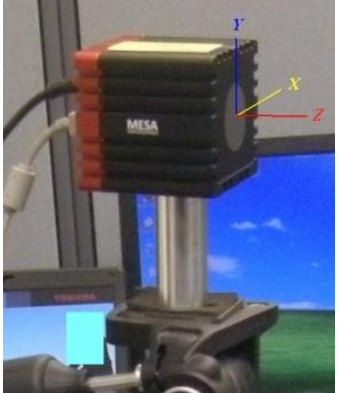
Figure 4. Coordinate axis of the SwissRanger SR4000 camera.